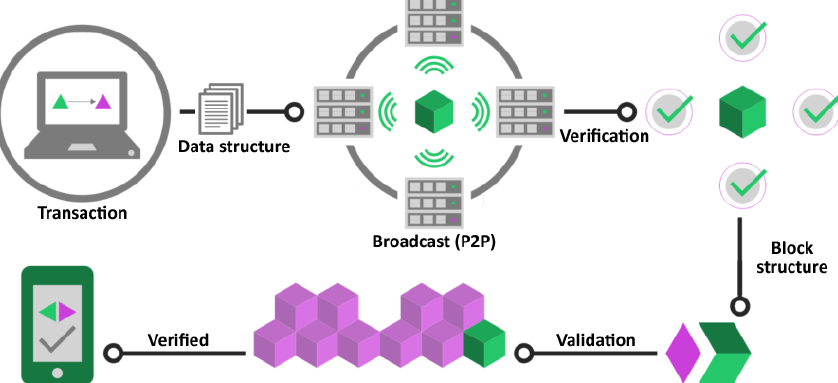
Figure 5. Proposed topology for the blockchain and the